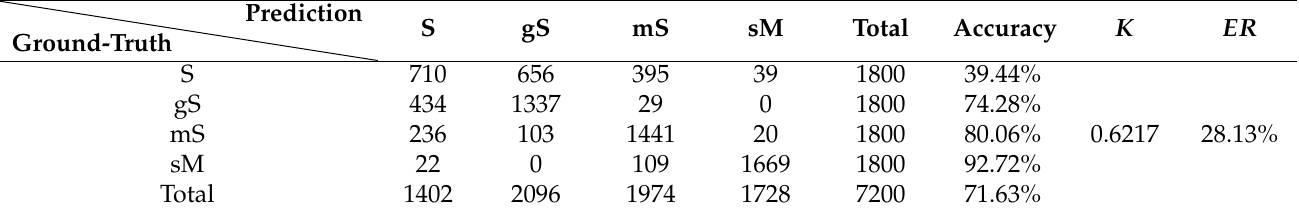
Table 4. Classification results of the Random Forest model using Wavelet Transform. Ground-Truth